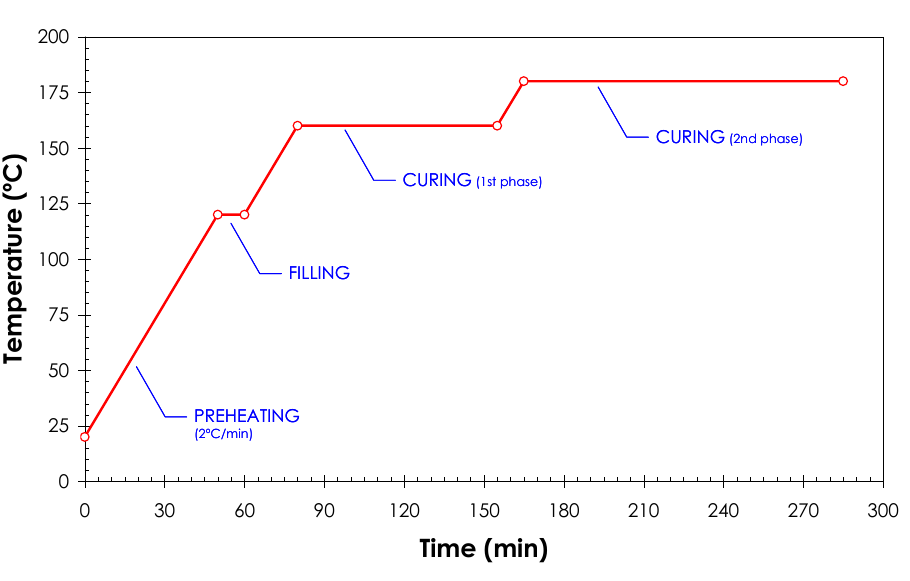
Figure 5. Thermal cycle considered for RTM6.